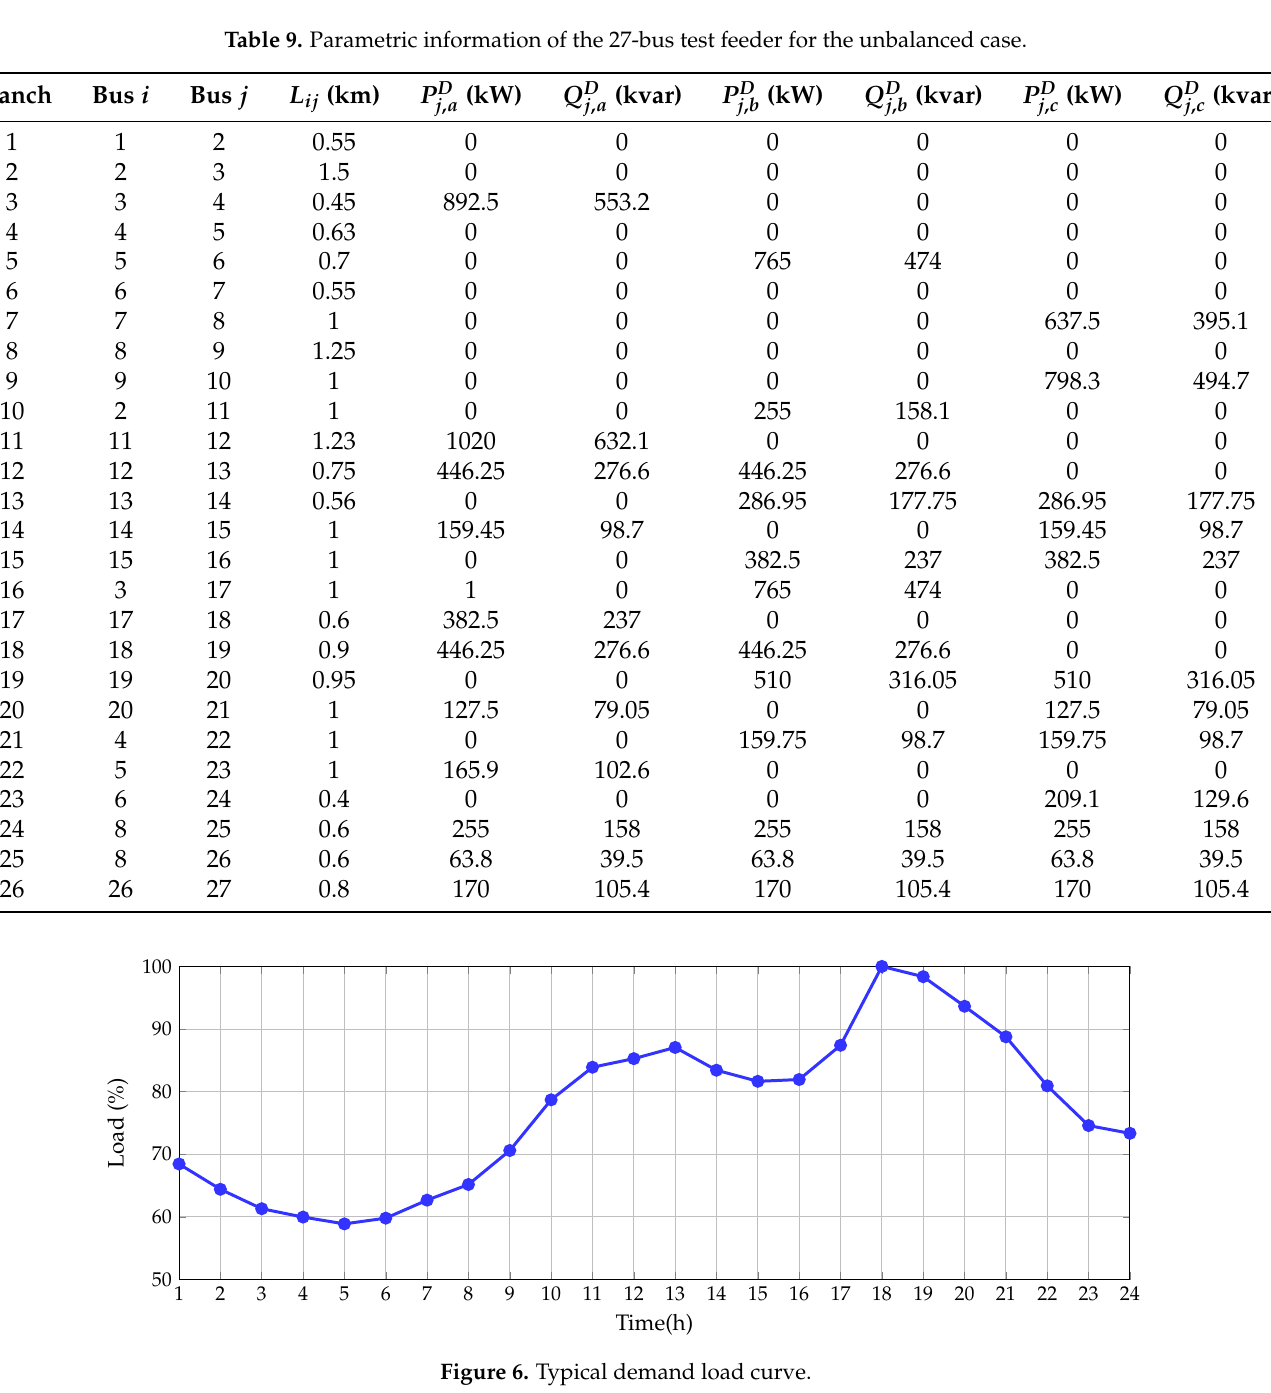
Figure 6. Typical demand load